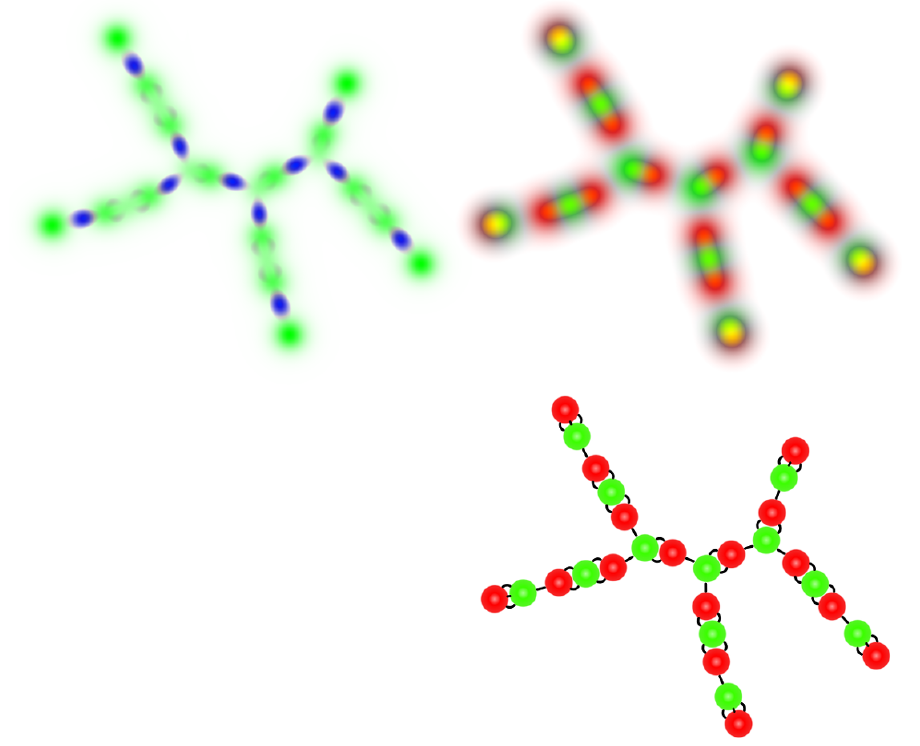
Figure 13 : ( Q 1 ; Q 2 ) = (4 ; 3) nonminimal vortex stick network. The (cid:12)gure contains 3 elements from left to right and then down: an energy density plot, a (cid:12)eld density plot and a sketch of how the red and green vortices are interconnected. The (cid:12)rst two plots are made using the coloring scheme of (cid:12)gure